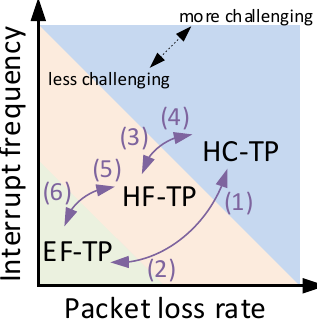
Figure 6. TP switching